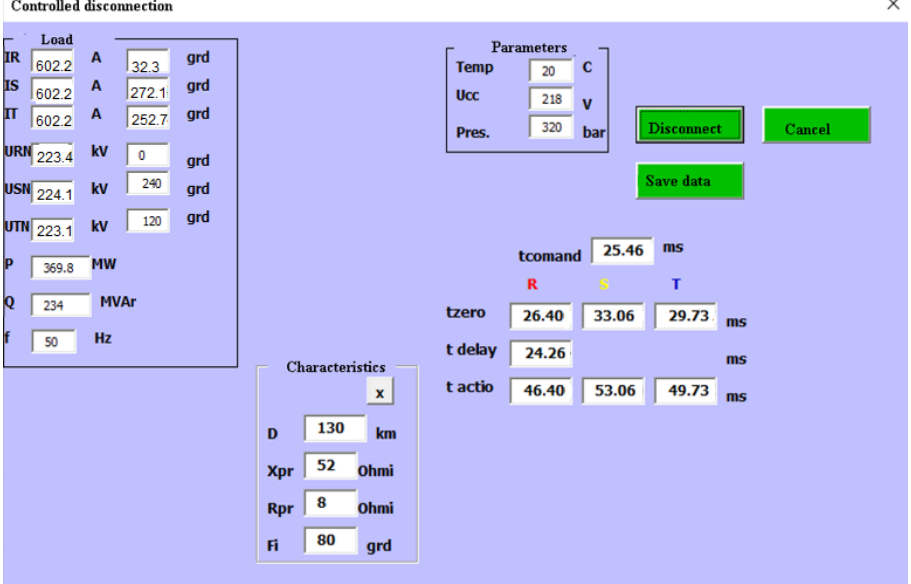
Figure 26. The control screen of the circuit breaker’s controlled disconnection.